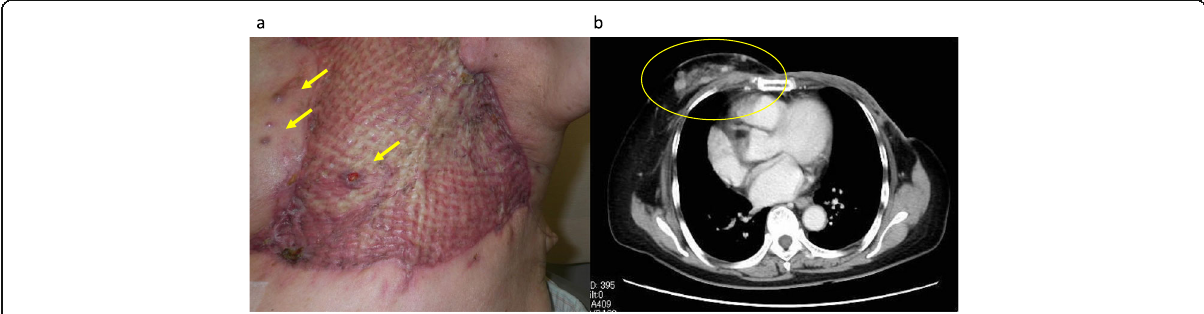
Fig. 4 The following two recurrences appeared 40 days after surgery: a Local recurrence on the skin graft and skin metastases of the contralateral breast (indicated by arrows) and b Enhanced nodules in the contralateral breast as detected by MRI